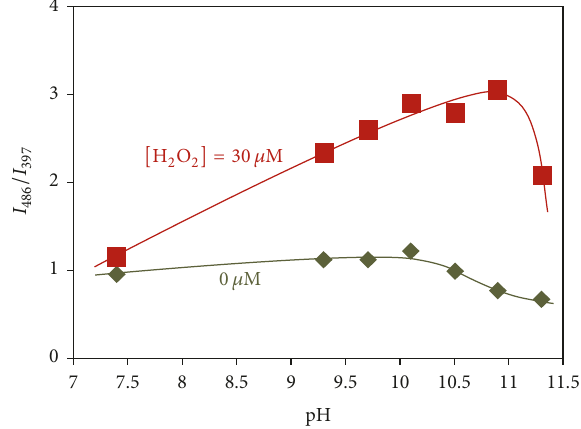
Figure 5: Relative change in excimer (486nm) to monomer (397 nm) emission intensity ratios as a function of H 2 O 2 concen- trations for aqueous solutions of the polymers buffered by 10mM CAPS (pH